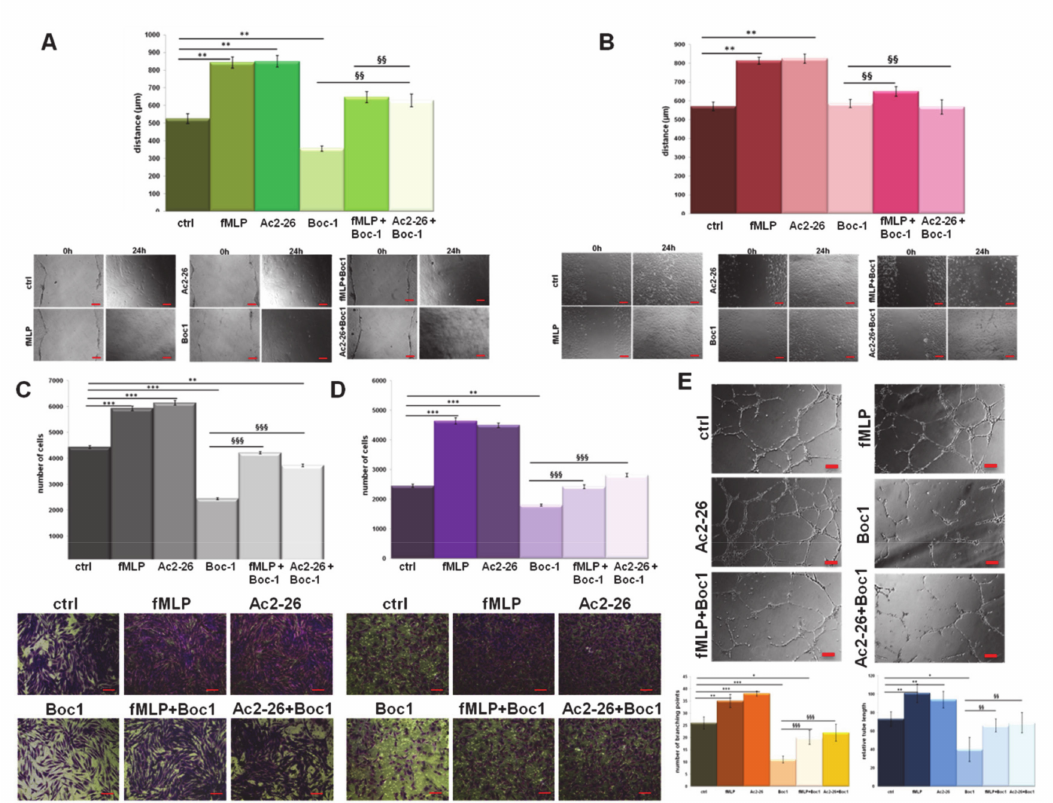
Figure2. E ff ectsofFormylpeptidereceptors(FPRs)agonistsandantagonistsonBJandHumanumbilical vein endothelial cell (HUVEC) cells. Results of Wound-Healing assay on ( A ) BJ and ( B ) HUVEC cells treated with formyl-Methionine-Leucine-Phenylalanine (fMLP) (50 nM), Ac2-26 (1 µ M), and N-tert-butyloxycarbonyl-Met-Leu-Phe (Boc1) (100 µ M), with related images. Analysis of invasion distance of BJ ( C ) and HUVEC ( D ) with relative bright field images treated or not with FPR agonists and antagonist at the same concentration. Bar = 50 µ m. ( E ) Representative images of tube formation by HUVEC cells seeded for 12 h on Matrigel: Endothelial Cell Growth Basal Medium-2 (EBM-2) 1:1 with the same treatment. Analysis of tube length and number of branches calculated by ImageJ (Angiogenesis Analyzer tool) software. Bar = 100 µ m. Data represent the mean of three independent experiments ± standard deviation with similar results.* p < 0.05; ** p < 0.01; *** p < 0.001 treated cells vs. untreated controls; §§ p < 0.01; §§§ p < 0.001 for each point of EVs + Boc-1 vs. Boc-1